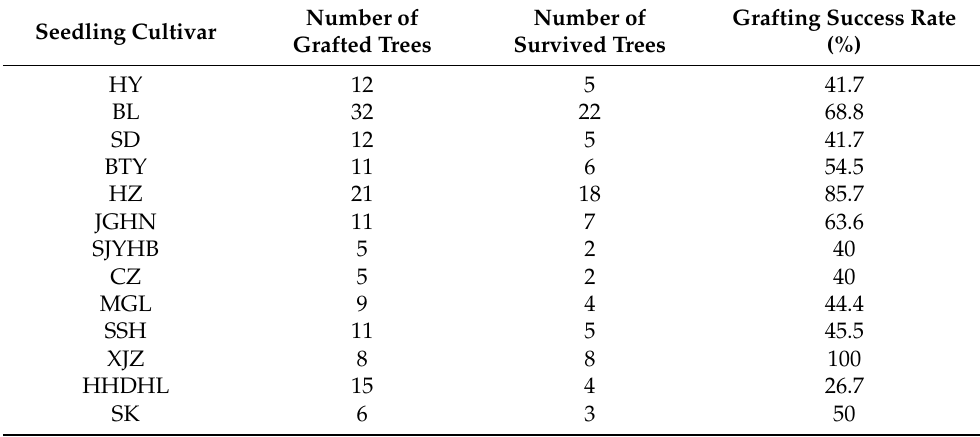
Table 1. Numbers of grafted ‘Lingfengnuo’ trees, survived trees, and graft success rates on seedling rootstocks of different